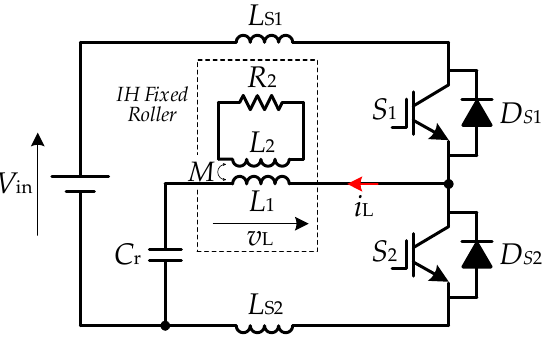
Figure 3. Series load resonant high-frequency soft-switching inverter.